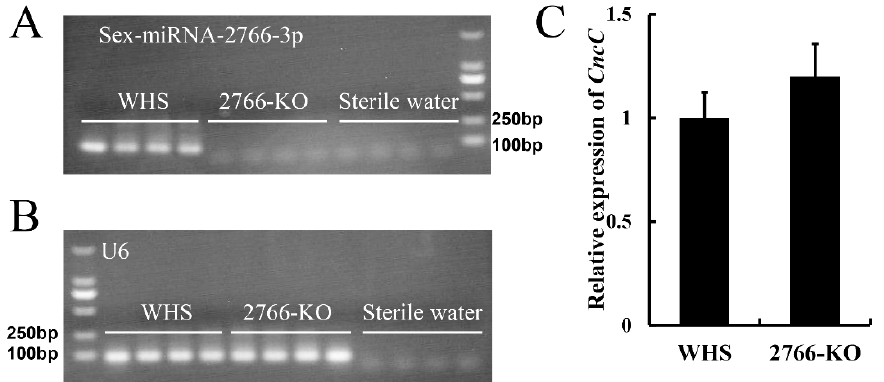
Figure 3. The examined expression of Sex-2766-miRNA-3p ( A ), U6 ( B ) and CncC ( C ) at transcrip- tional level between WHS and 2766-KO